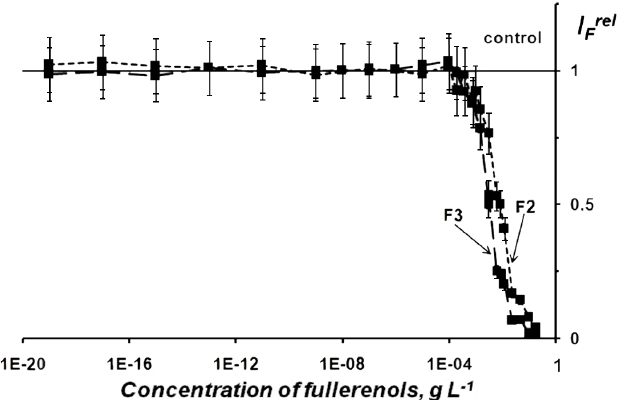
Figure 1. Bioluminescence intensity, I rel , at different concentrations of fullerenols F2 and F3 for the cellular assay.